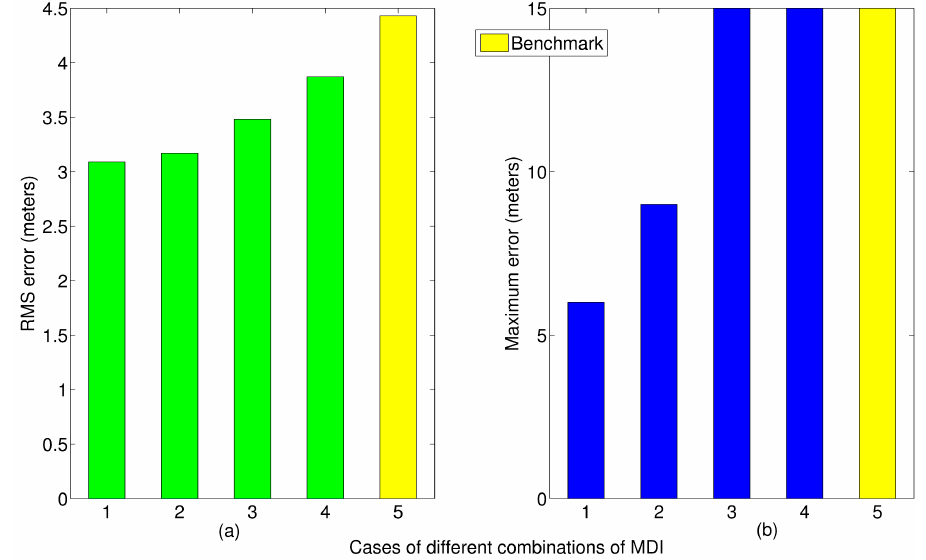
Figure 6. Positioning errors in terms of RMSE ( a ) and maximum errors ( b ) when the different cases of MDI combinations are applied. The yellow bars (marked as “5” of x -axis) represent the results of the baseline method